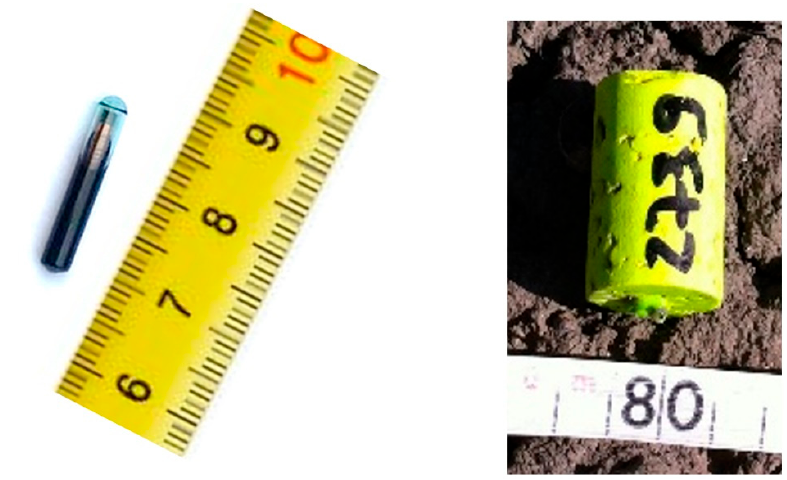
Figure 2. On the left a picture if the RFID tag, and on the right a cork stopper with RFID inside, painted and numbered.